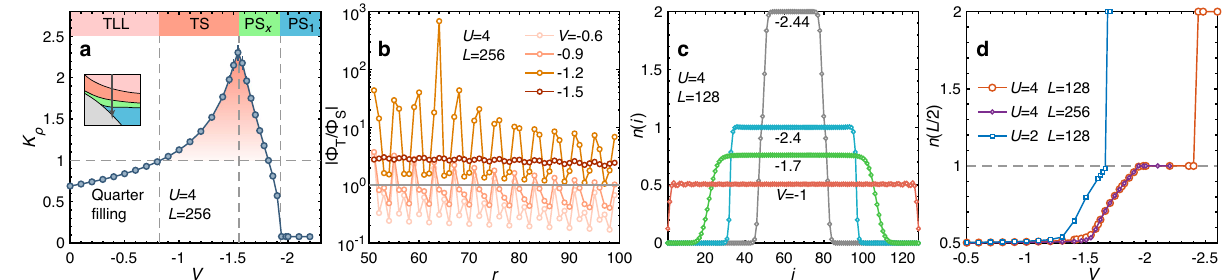
Fig. 5 Results of EHM at quarter fi lling. We show in a the mini phase diagram and Luttinger parameter K ρ , and b accordingly the ratio between triplet and singlet pairings ∣ Φ T / Φ S ∣ that becomes greater than 1 in the emergent TS phase. The K ρ results in the PS x and PS 1 are computed within the clustered part (see Supplementary Note 3). c The charge distribution n ( i ) in TS ( V = − 1), PS x ( V = − 1.7), PS 1 ( V = − 2.4), and PS 2 ( V = − 2.44) phases, respectively. d The charge densities n ( L /2) measured at the center of the system are plotted versus